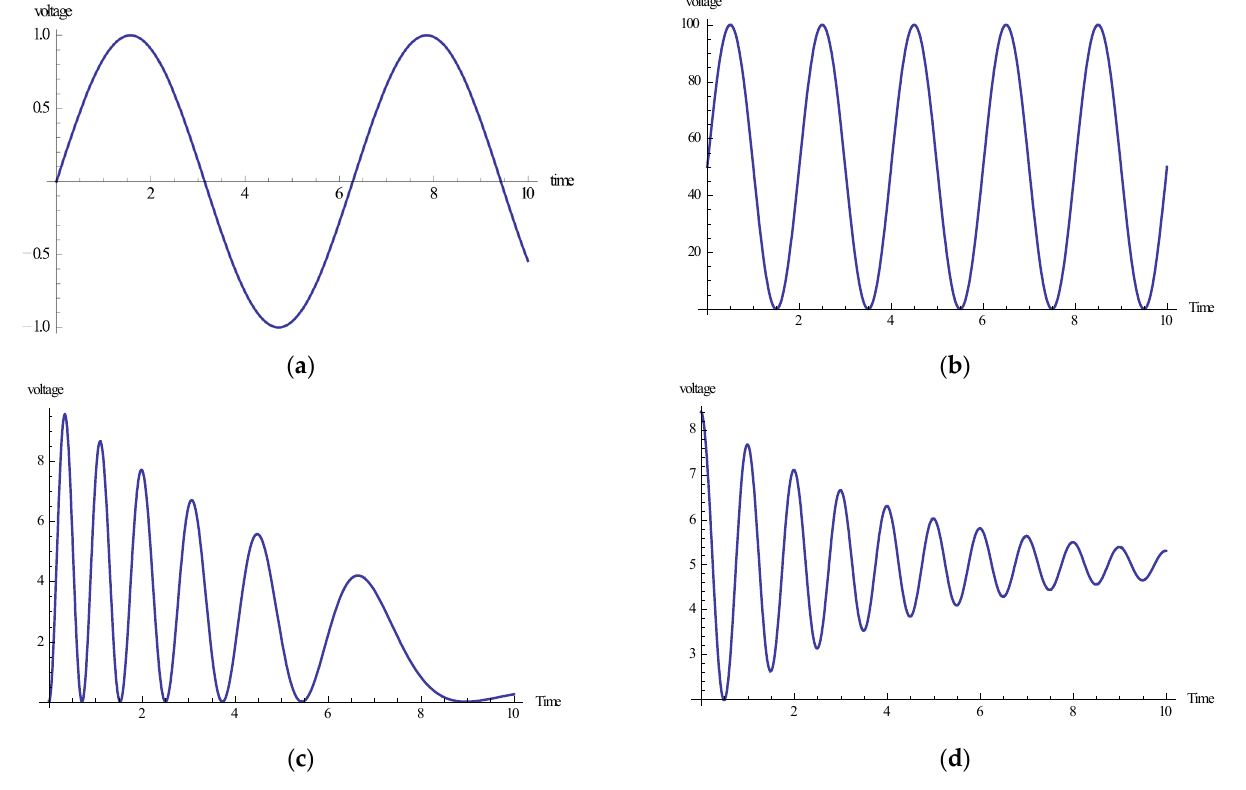
Figure 4. Input voltage signals of all four cases of both LMM ‐ NNs and BRM ‐ NNs. ( a ) Input Signal. ( b ) Input Signal 2. ( c ) Input Signal 3. ( d ) Input Signal 4. Table 2. Output displacement (m) datasets of all cases of both